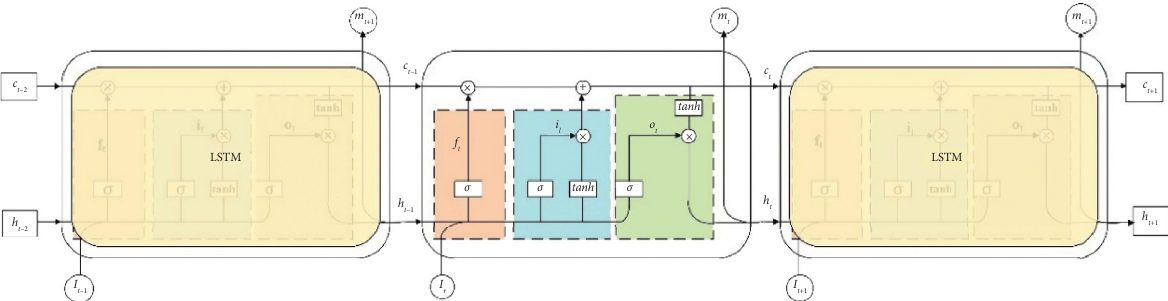
Figure 2: Schematic of the LSTM